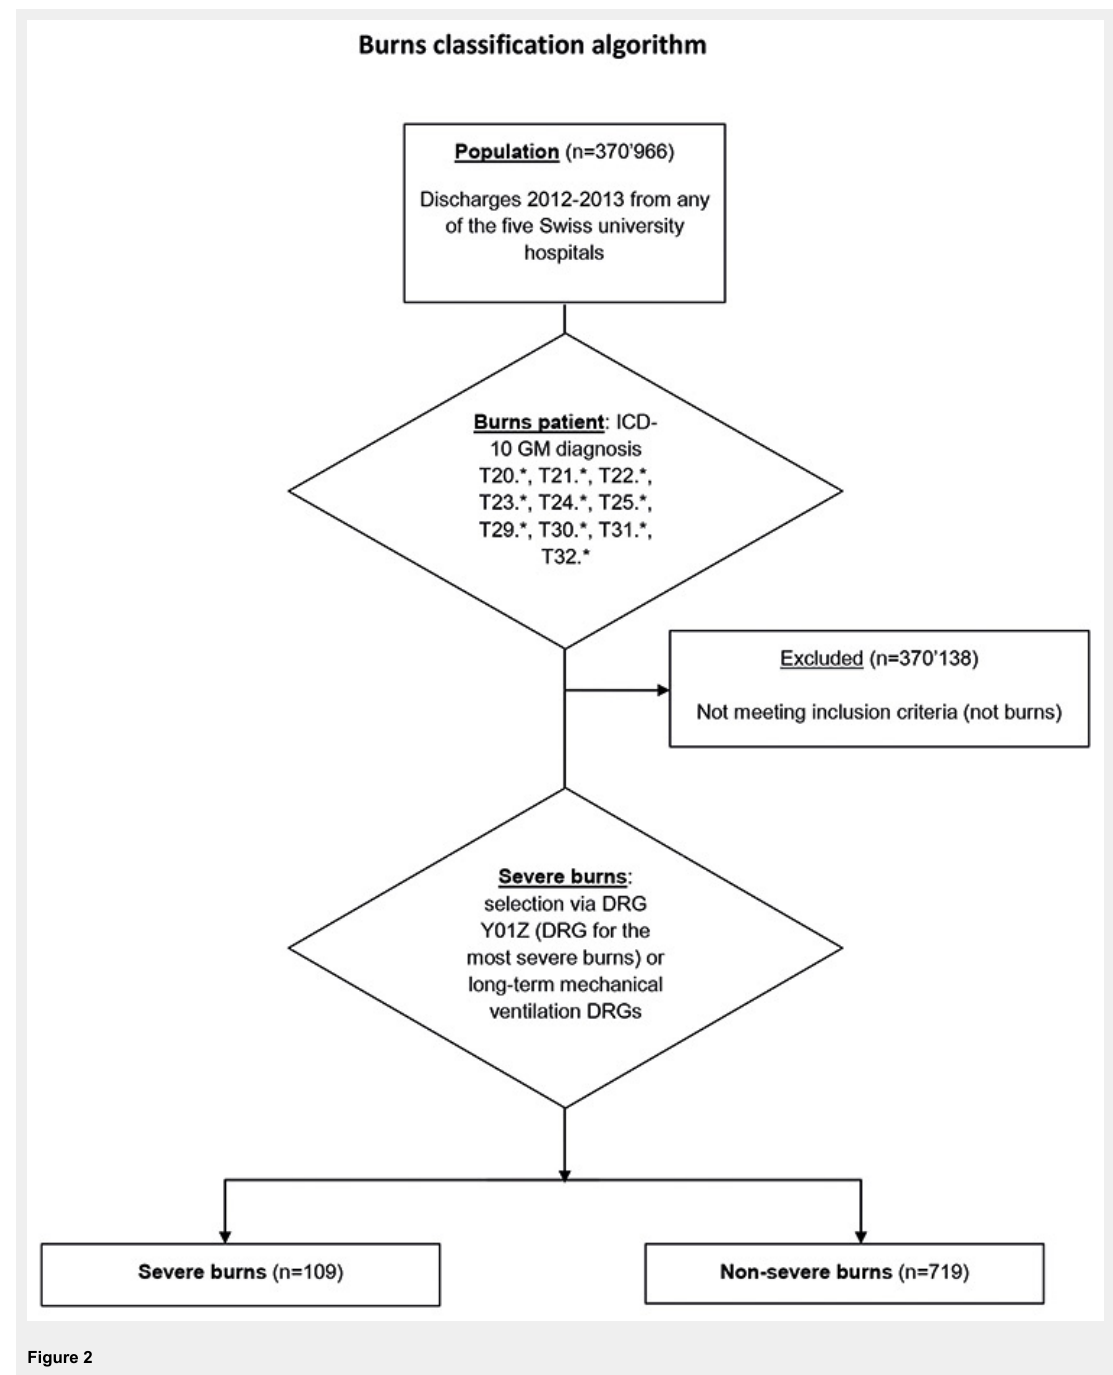
Figure 2 Burns classification algorithm. ICD10-GM = International Classification of Diseases, 10th revision, German